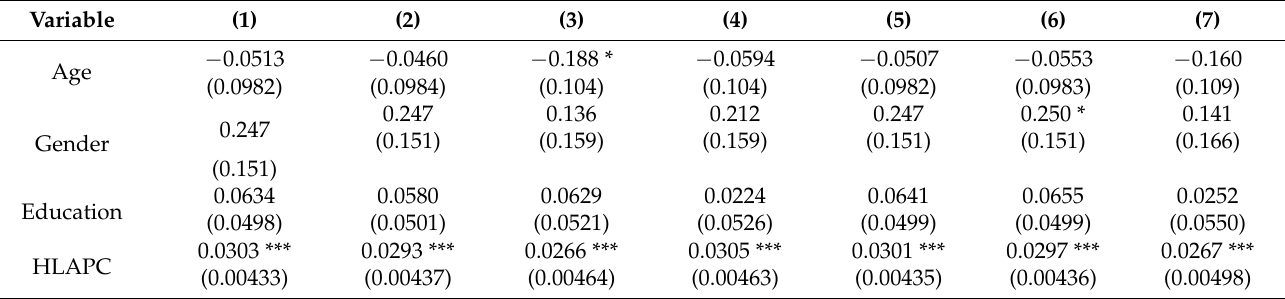
Table 5. Pooled results (dependent variables: